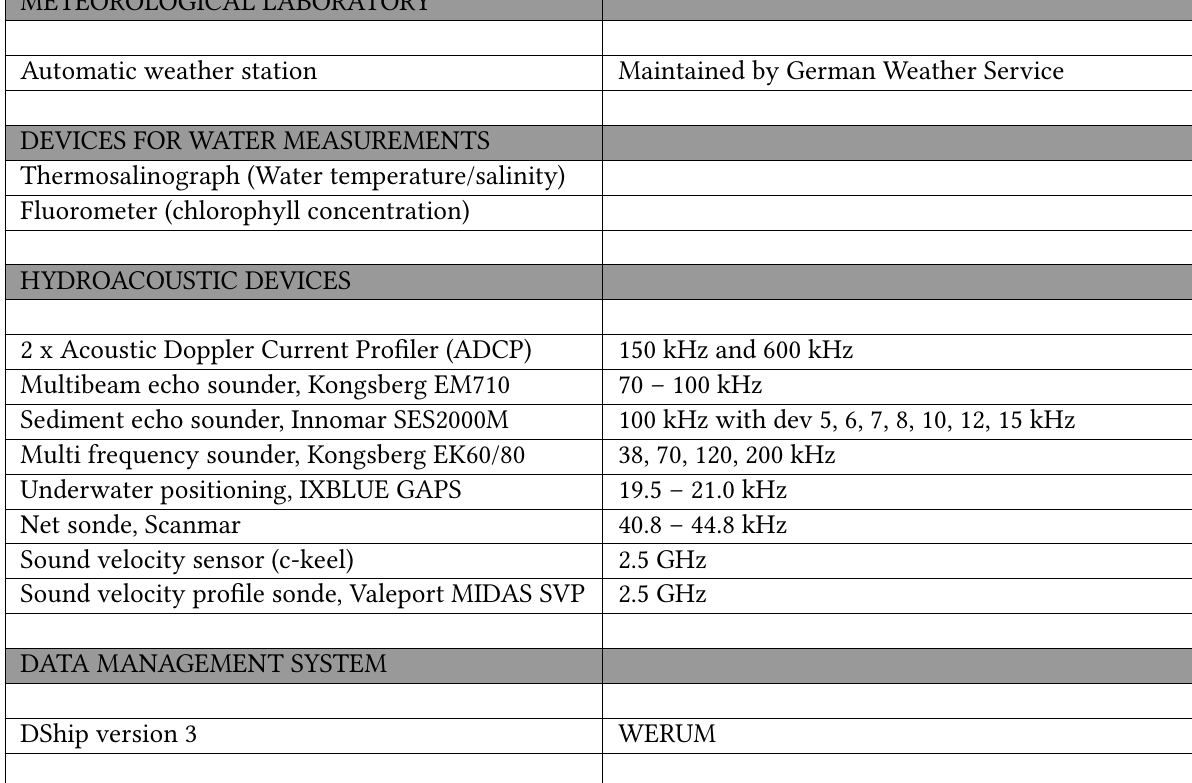
Table 3: Scientific devices and data management systems installed on board